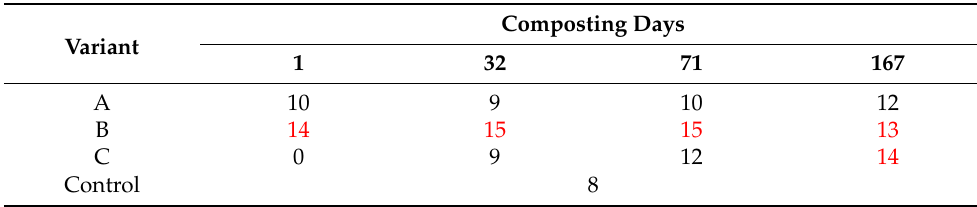
Table 2. Number of lettuce seedlings ( Lactuca sativa L.) after 20 days of incubation (number per pot, mean